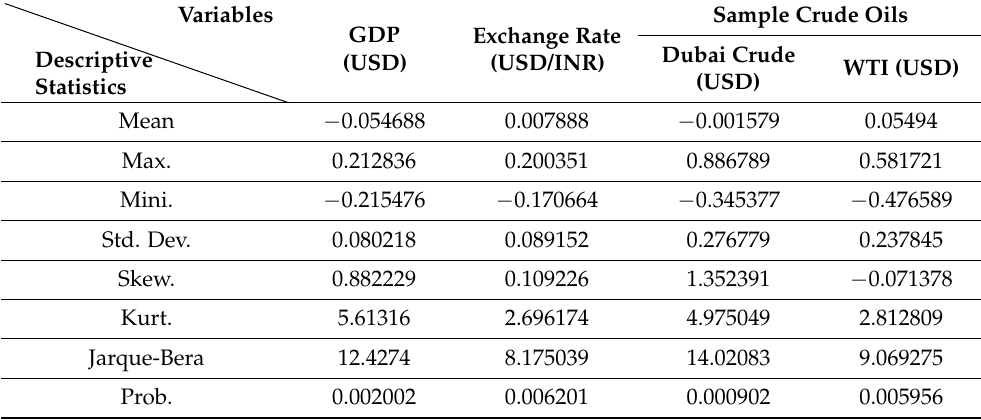
Table 2. The Results of Descriptive Statistics for Crude Oil Price on GDP and Exchange Rate (USD/INR) during the period from 1990 to